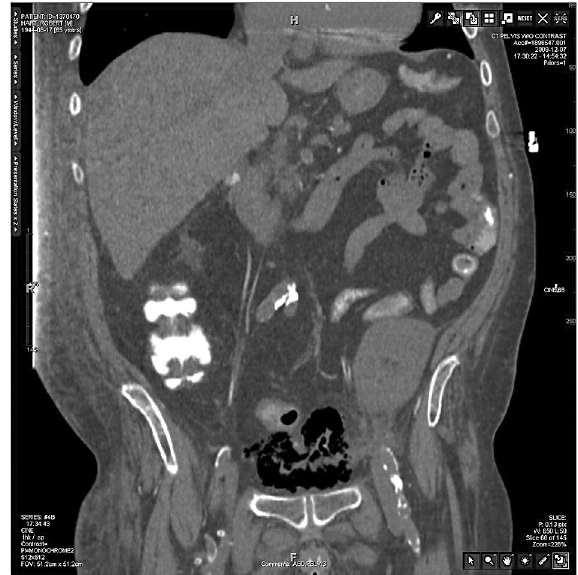
Figure 3 – A coronal reconstruction shows debries and an ad- herent ileal loop outlined by the gas-filled bladder. A transplant kidney is seen on the left side, with only minimal stranding in the perirenal space. However edema is seen peripelvic and peri- ureteral